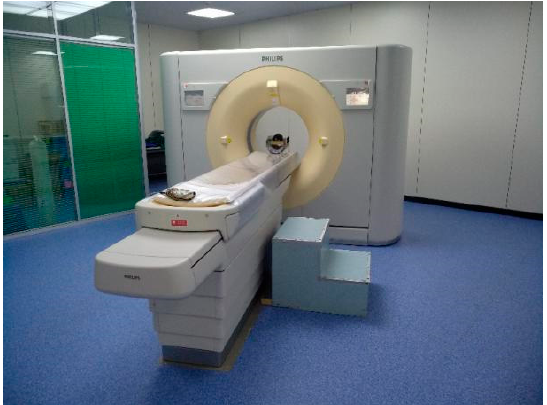
Figure 4. The Brilliancei CT scanning equipment.